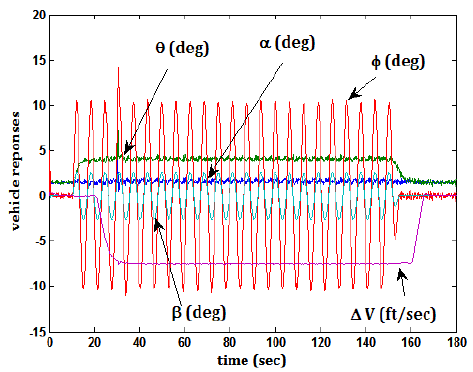
Figure 17. Vehicle responses for Task